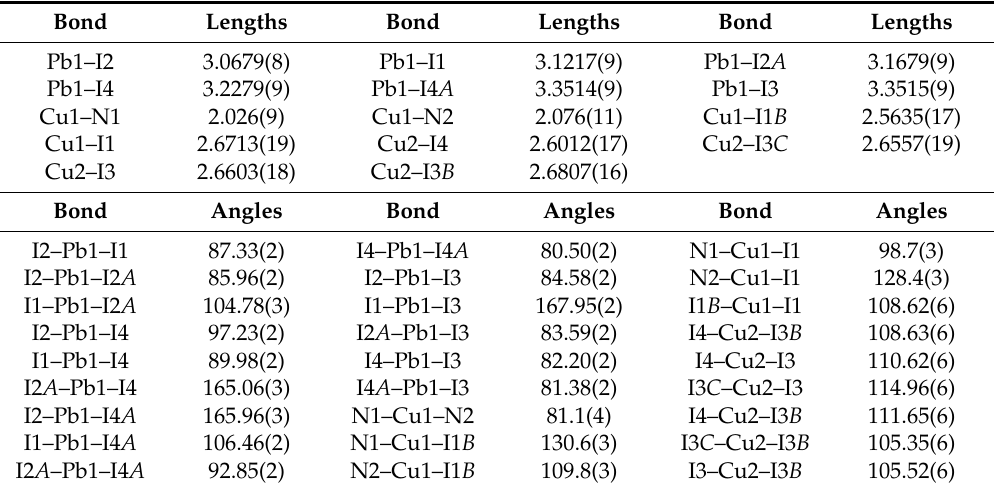
Table 2. Selected bond lengths (Å) and bond angles ( ◦ ) for 1